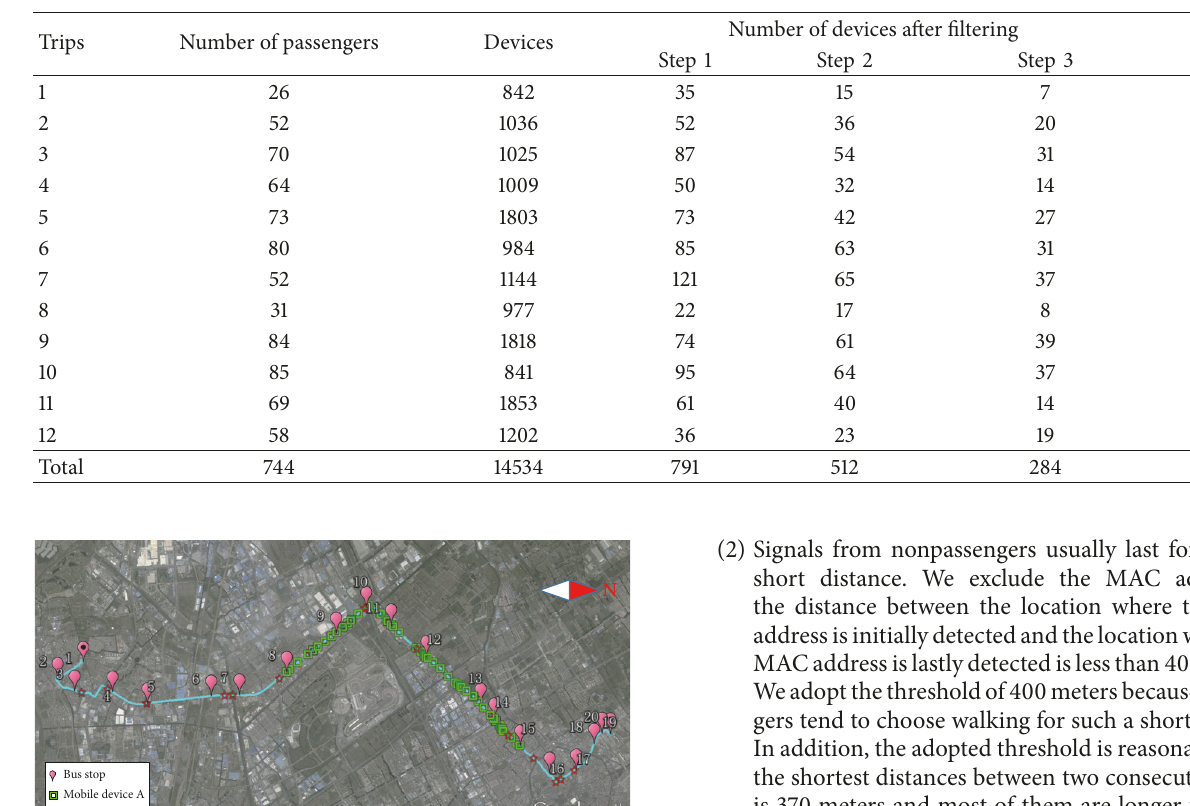
Table 1: Passenger and device observations by bus trip.